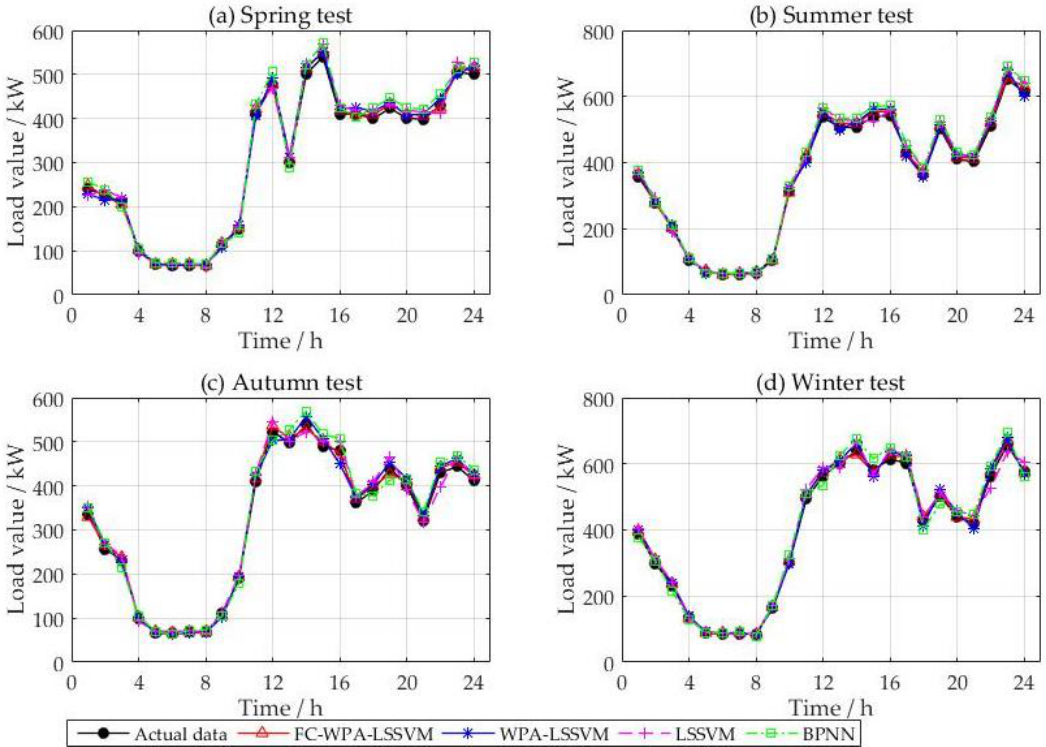
Figure 9. Forecasting results: ( a ) forecasting results of Spring test; ( b ) forecasting results of Summer test; ( c ) forecasting results of Autumn test; ( d ) forecasting results of Winter test.